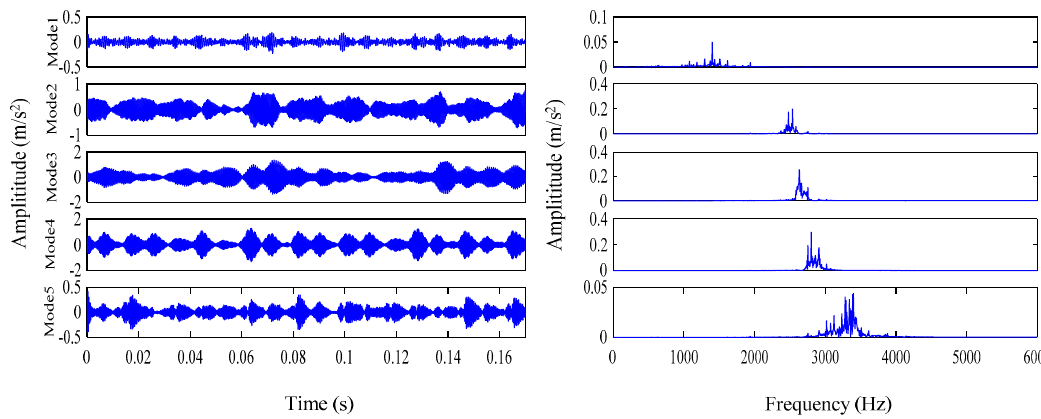
Figure 22. Decomposition results and corresponding frequency spectrum of modes by IVMD.